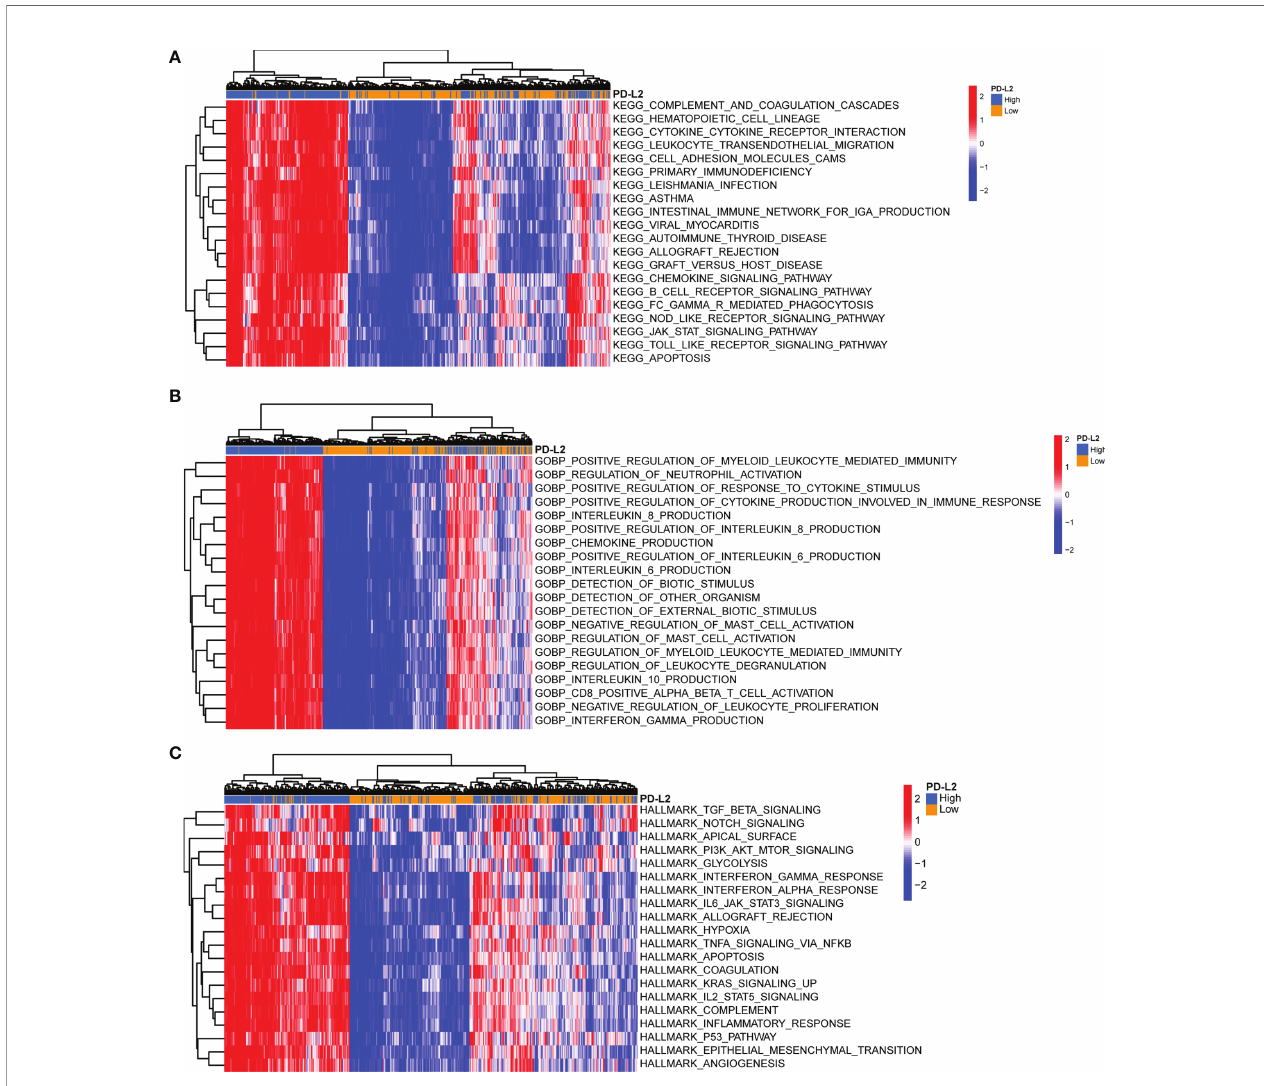
FIGURE 7 | Gene Set Variation Analysis (GSVA) of biological processes and tumor-related pathways associated with the expression of PD-L2 in the TCGA cohort. Top 20 signi fi cant Kyoto Encyclopedia of Genes and Genomes (KEGG) pathways (A) , Gene Ontology (GO) biological processes (B) , and hallmark pathways (C) identi fi ed by GSVA analysis. GSVA, Gene Set Variation Analysis; GO, Gene Ontology; KEGG, Kyoto Encyclopedia of Genes and